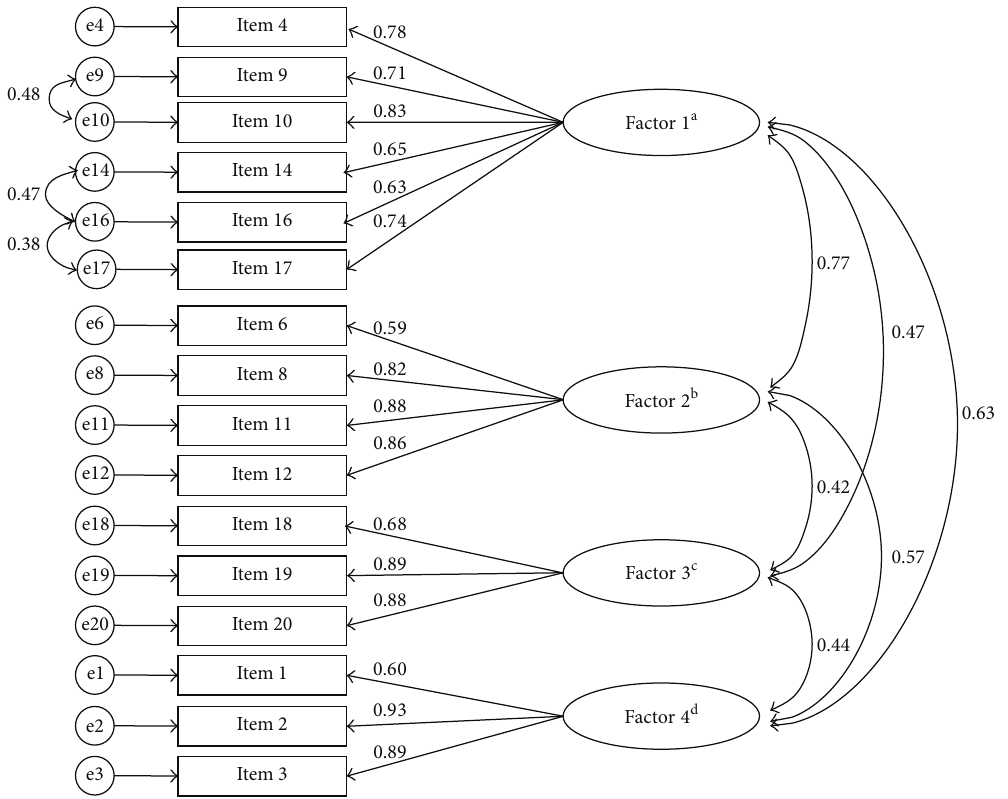
Figure 1: Confirmatory factor analysis for the Korean version of the Diabetes Management Self-Efficacy Scale. e: error term. a Factor 1: nutrition. b Factor 2: physical exercise/body weight. c Factor 3: medical treatment. d Factor 4: blood